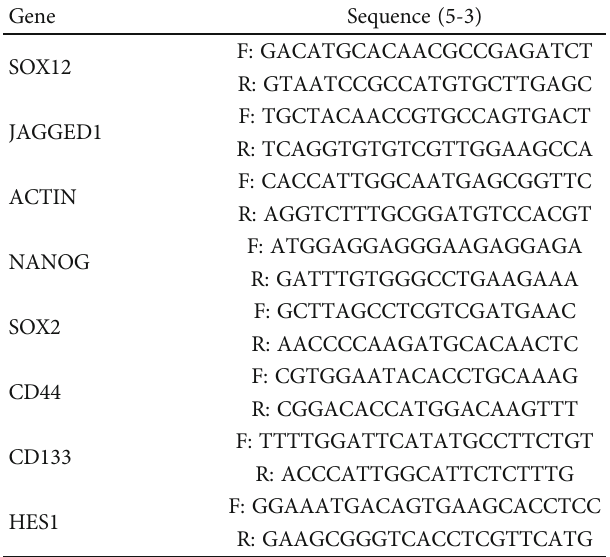
Table 1: The primers for RT-qPCR.